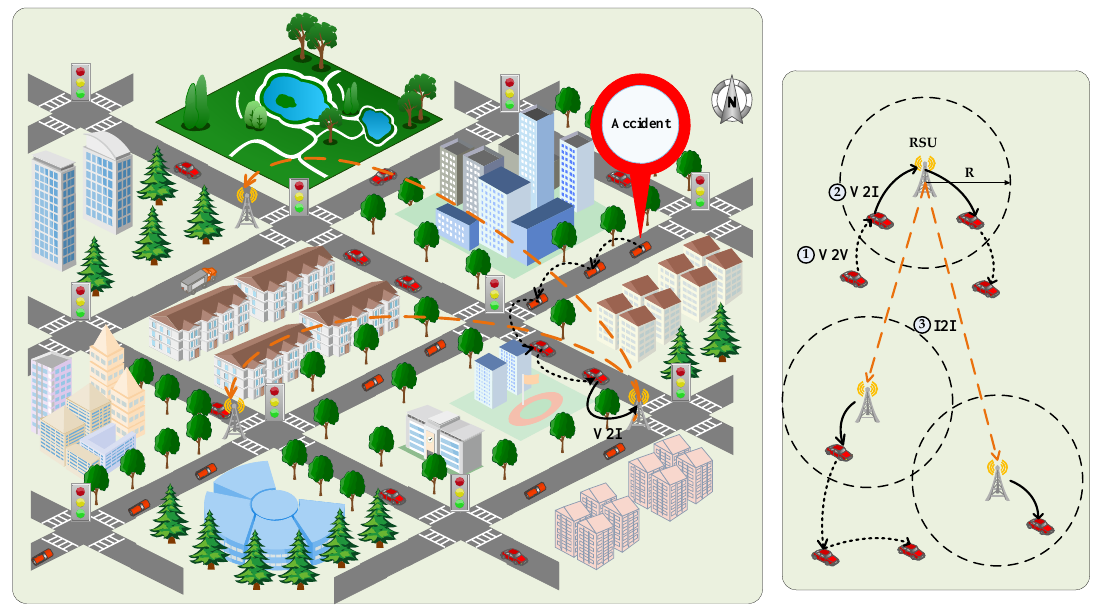
Figure 7. The emergency information dissemination scenario.